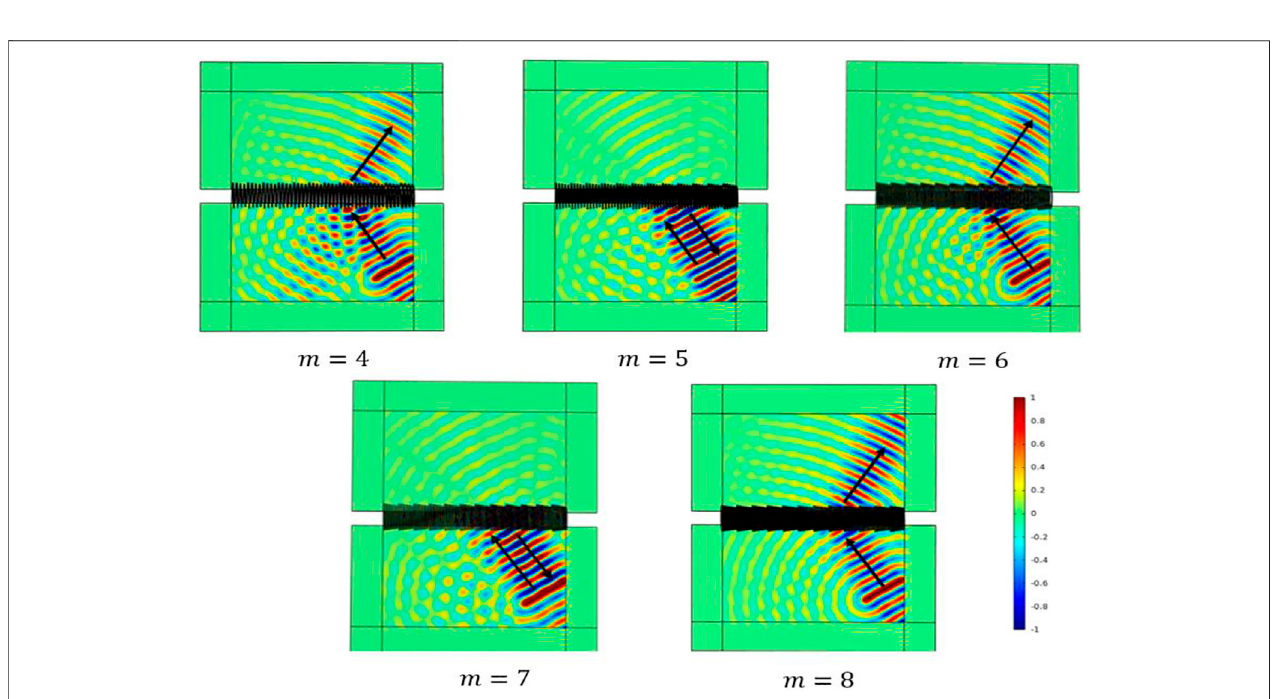
FIGURE 6 | When the incident angle is 30 ° , the corresponding transmission wave fi elds of metasurfaces with different unit cell numbers.